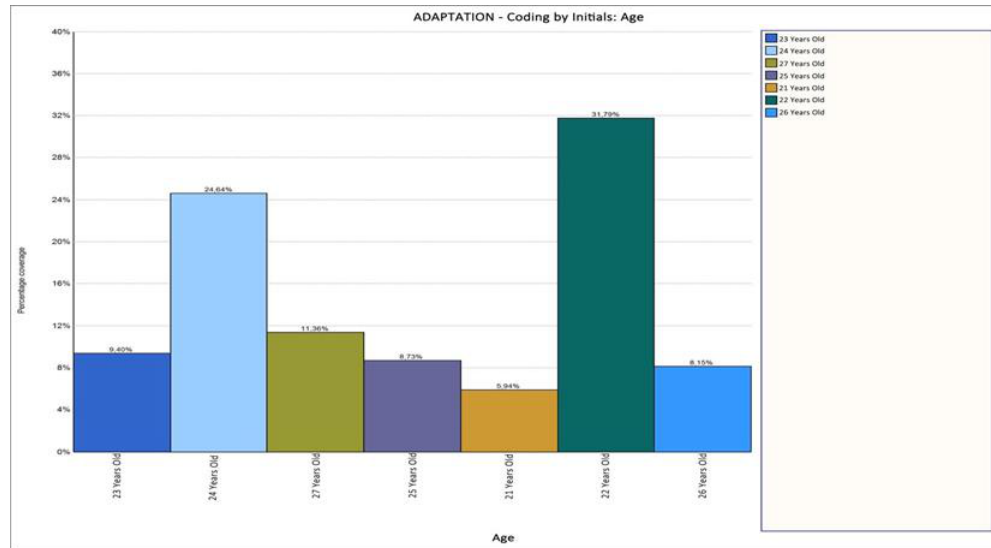
Fig. 13. Demographic description age affects adaptation